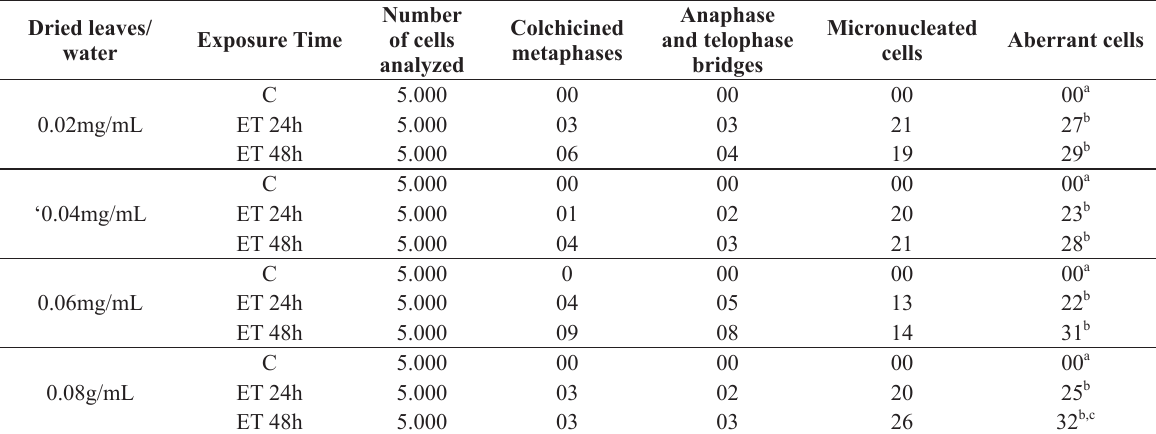
Number of cells with colchined metaphases, bridges in anaphase and telophase and micronucleated cells, and total of aberrant cells treated with the infusion of Phyllanthus niruri leaves at concentrations of 0.02, 0.04, 0.06 and 0.08 mg/mL after 24 h, 48 h and 7 days of